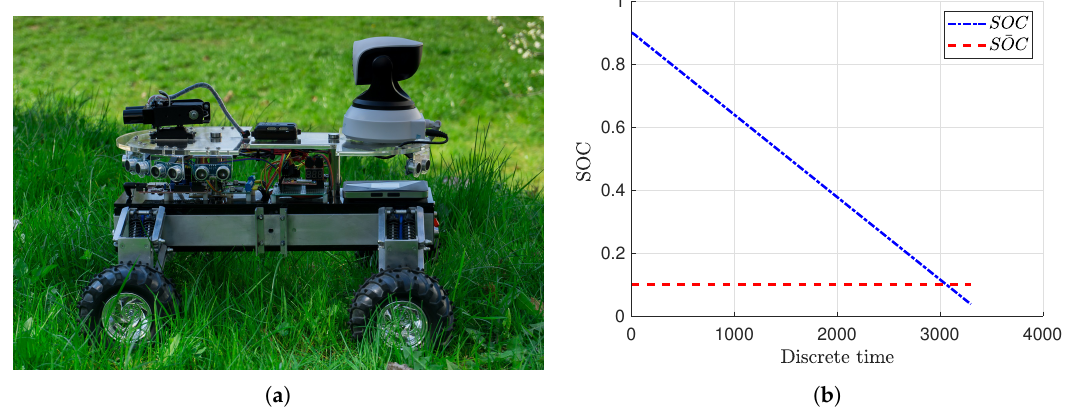
Figure 9. Automated Guided Vehicle ( a ) and its State of Charge ( b